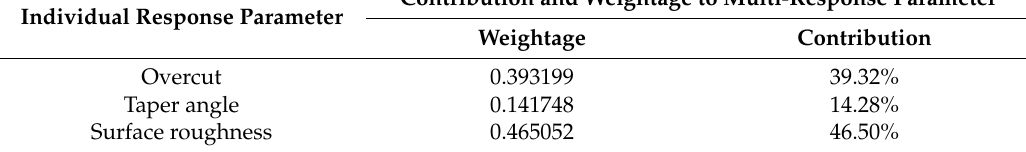
Table 9. Contribution of individual response to multi-response